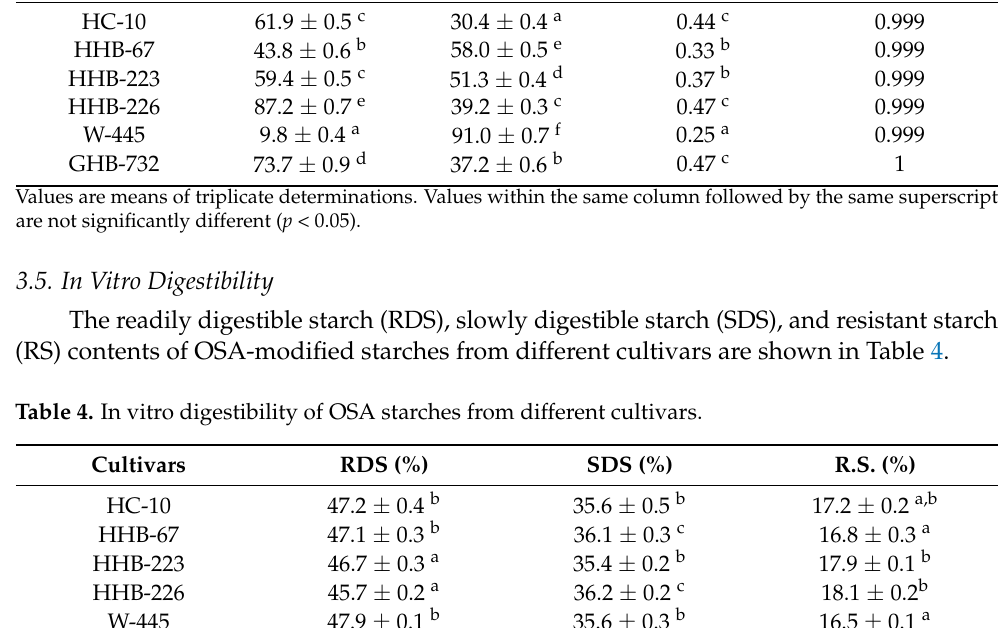
Table 3. Steady shear properties of OSA-modified starches fitted with Herschel–Bulkley model. Cultivars σ o (Pa) K (Pa.s) n